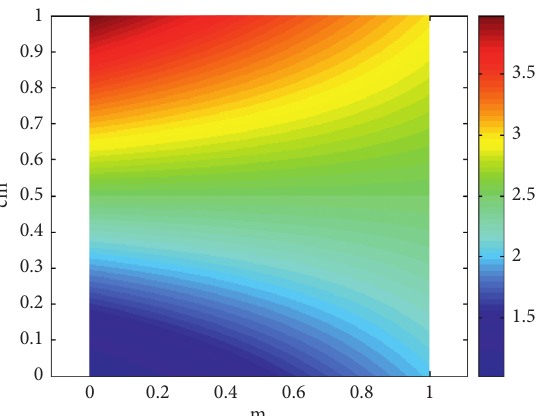
Figure 3: Treatment map of distance between surface working face and cut hole in subsidence area ( d � 30